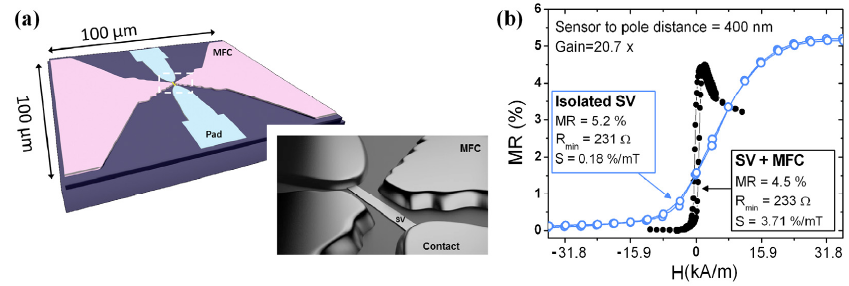
Figure 11. ( a ) Illustration of an integrated device combing SV sensor and MFCs; ( b ) Transfer curves comparing the isolated SV sensor with the corresponding device including the MFC [81].